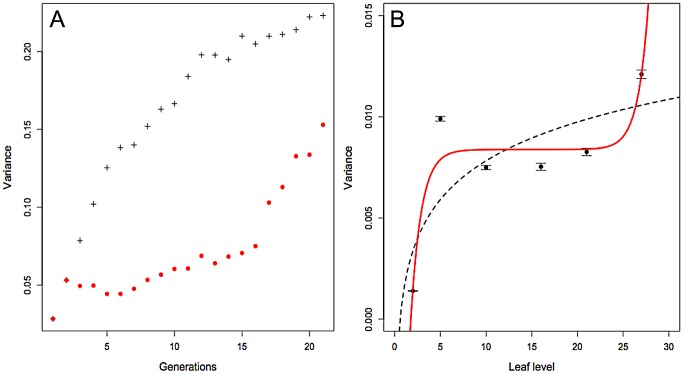
Monitoring of the bottleneck size changes during disease progression.
A. Among-populations variance of allele frequency of a diallelic neutral locus over time when the effective size of each population is (i) always equal to 10 (black crosses); (ii) equal to 10 until generation 2, then equal to 100 until generation 15, and then equal to 10 again (red circles). All populations start with the same initial allele frequency of 0.5. B. At each indicated leaf level, the variance of Mys4 frequency was estimated among 40 replicate plants. The equi-competitiveness of Mys4 and Mys7 was again confirmed in this experiment, by showing that the linear regression of Mys4/Mys7 relative frequency over time is not different from 0 (p-value = 0.053; not shown). Confidence limits for variance values were obtained as in Figure 2B. Error bars indicate standard errors. Two functions were fitted to the variance values obtained over time. Red line: a hyperbolic-sinus function with the formula: y = d*(b/d+sinh(c*(x−a))); where a = 14.84, b = 8.37E-03, c = 0.87 and d = 2.28E-07; this function has an AIC = −54504.68. Dashed line: a logarithmic function with the formula: y = a+b*ln(x); where a = 1.45E-3 and b = 2.764E-3; this function has an AIC = −52021.35.